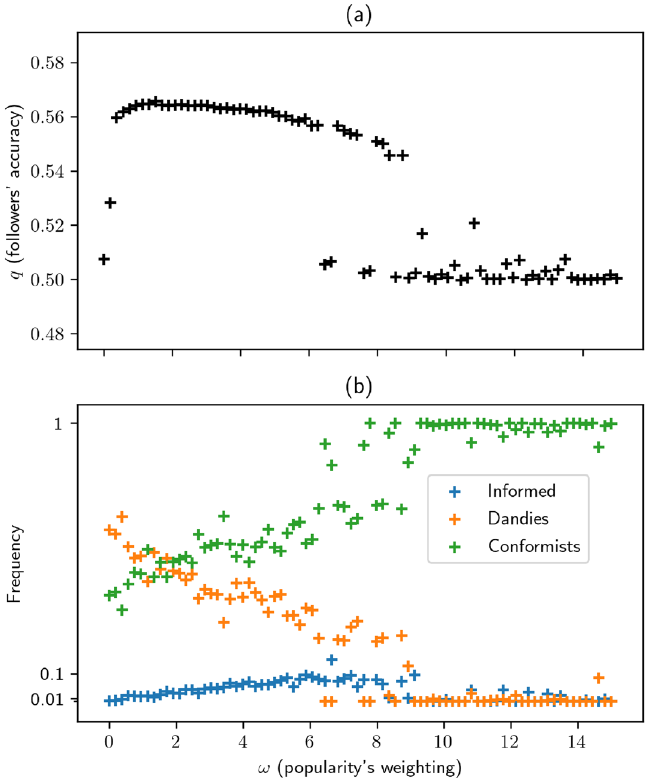
Figure 5. Effect of ω on accuracy q and phenotype prevalence, with p =.52, c=.01, α ⋆ = 1